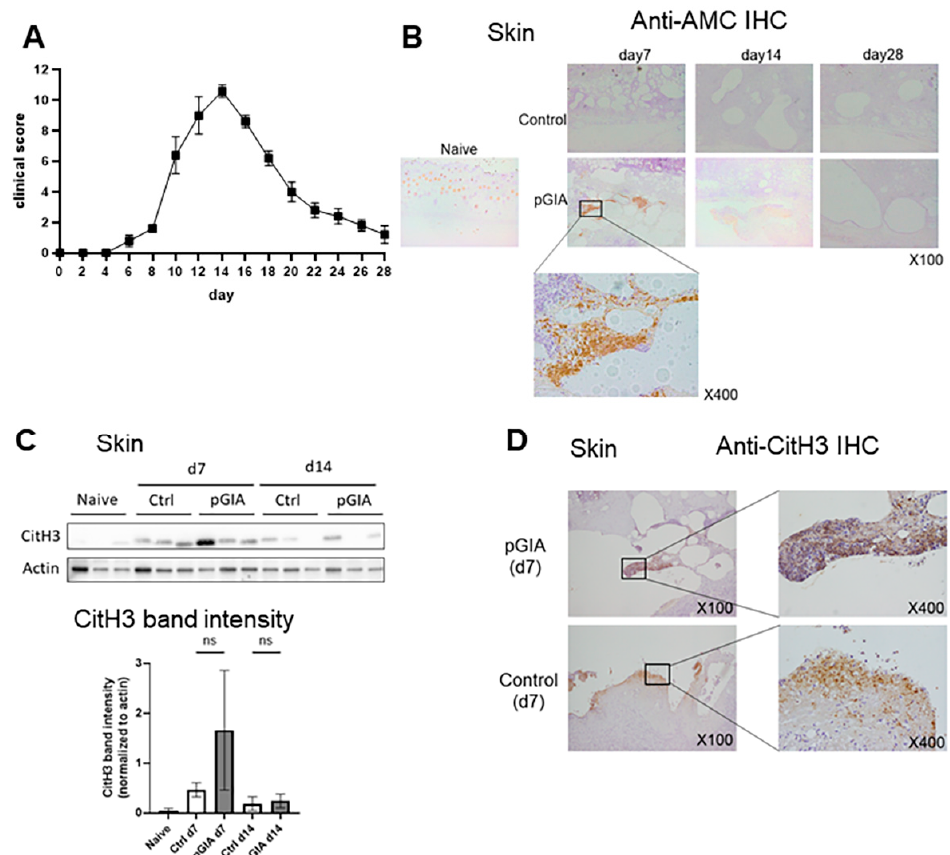
Figure 1. Citrullinated protein expression in the immunized skin of pGIA mice. ( A ) The clinical score of pGIA (means ± SEM), n = 5. ( B ) Skin sections were immunohistochemically stained with anti-modified citrulline (AMC) antibodies in pGIA or control mice. Hematoxylin was used as the counterstain. ( C ) Skin lysates from the pGIA mice and the control mice at days 0, 7, and 14 were subjected to Western blot analysis using anti-citrullinated histone 3 (CitH3) antibodies. Three mice were examined, and p values were calculated using ordinary one-way ANOVA with the post hoc Tukey test for multiple comparisons; ( D ) Skins were immunohistochemically stained with anti-CitH3 antibodies in the pGIA and control mice. Hematoxylin was used as the counterstain.